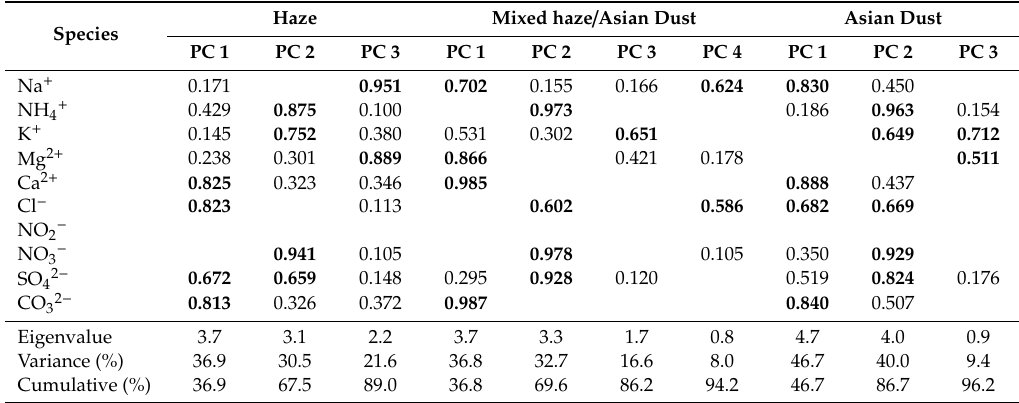
Table 2. Principal component analysis results for water-soluble species during the haze, mixed haze / Asian dust, and Asian dust episodes, with loading > 0.5 in bold. The analysis used a varimax rotation with Kaiser normalization.